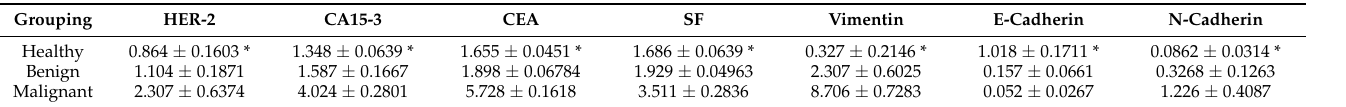
Figure 4. Comparison of serum HER-2 levels in each group. Note: Highly significant ( p < 0.05) as indicated by *.